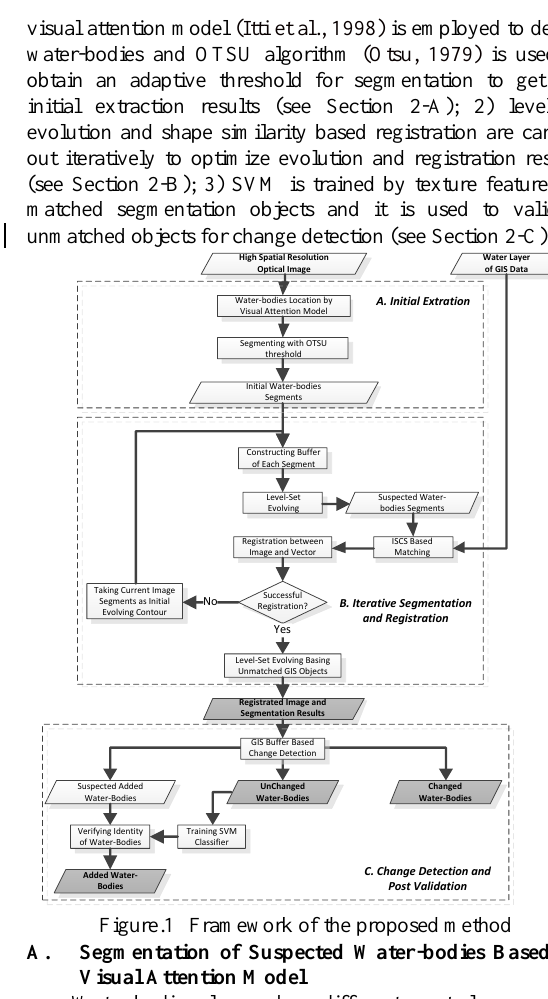
Figure.1 Framework of the proposed method